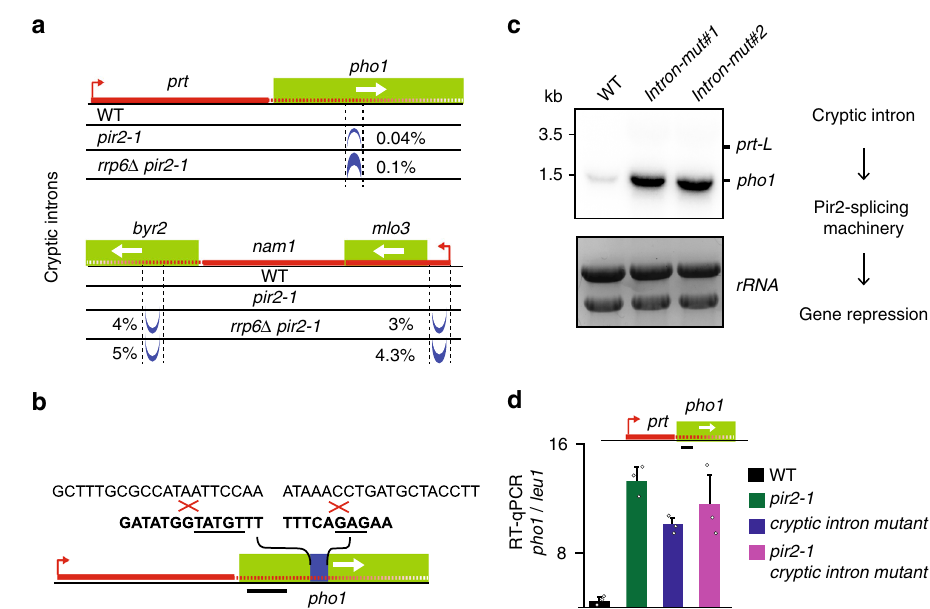
Fig. 3 The cryptic intron within lncRNA promotes downstream gene repression. a RNA-seq TopHat splice junctions showing cryptic introns. Numbers indicate the percentage of reads spliced. b Schematic showing splice site mutations in the cryptic intron of prt-pho1 . The deleted sequence is in bold and the inserted sequence is shown above. 5 ’ and 3 ’ splice sites are underlined. c Northern blot analysis of transcripts produced from the pho1 gene in WT and strains carrying the cryptic intron splice site mutations. The probe is shown in ( b ) as a black line. Source data are provided as a Source data fi le. Cells were grown in YEA medium. d RT-qPCR analysis of pho1 expression, normalized to leu1 . The ampli fi ed regions are indicated by the black line. Data are presented as mean values± SD for n = 3 biologically independent samples. Mean data distribution is represented by white